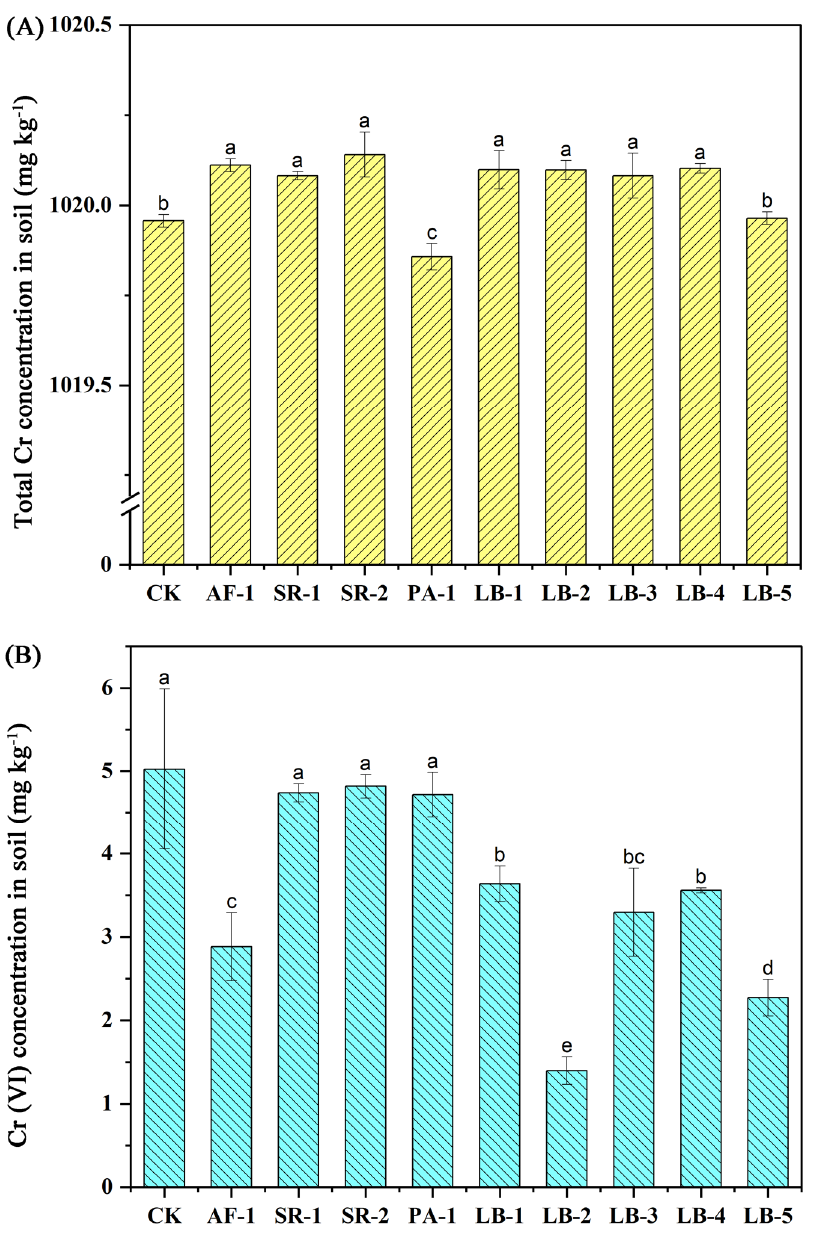
Figure 2. Total Cr and Cr (VI) concentration in the rhizosphere soil of different treatments. ( A ): Total Cr concentration in soil; ( B ): Cr (VI) concentration in soil. The same le(cid:308)er means no significant difference.